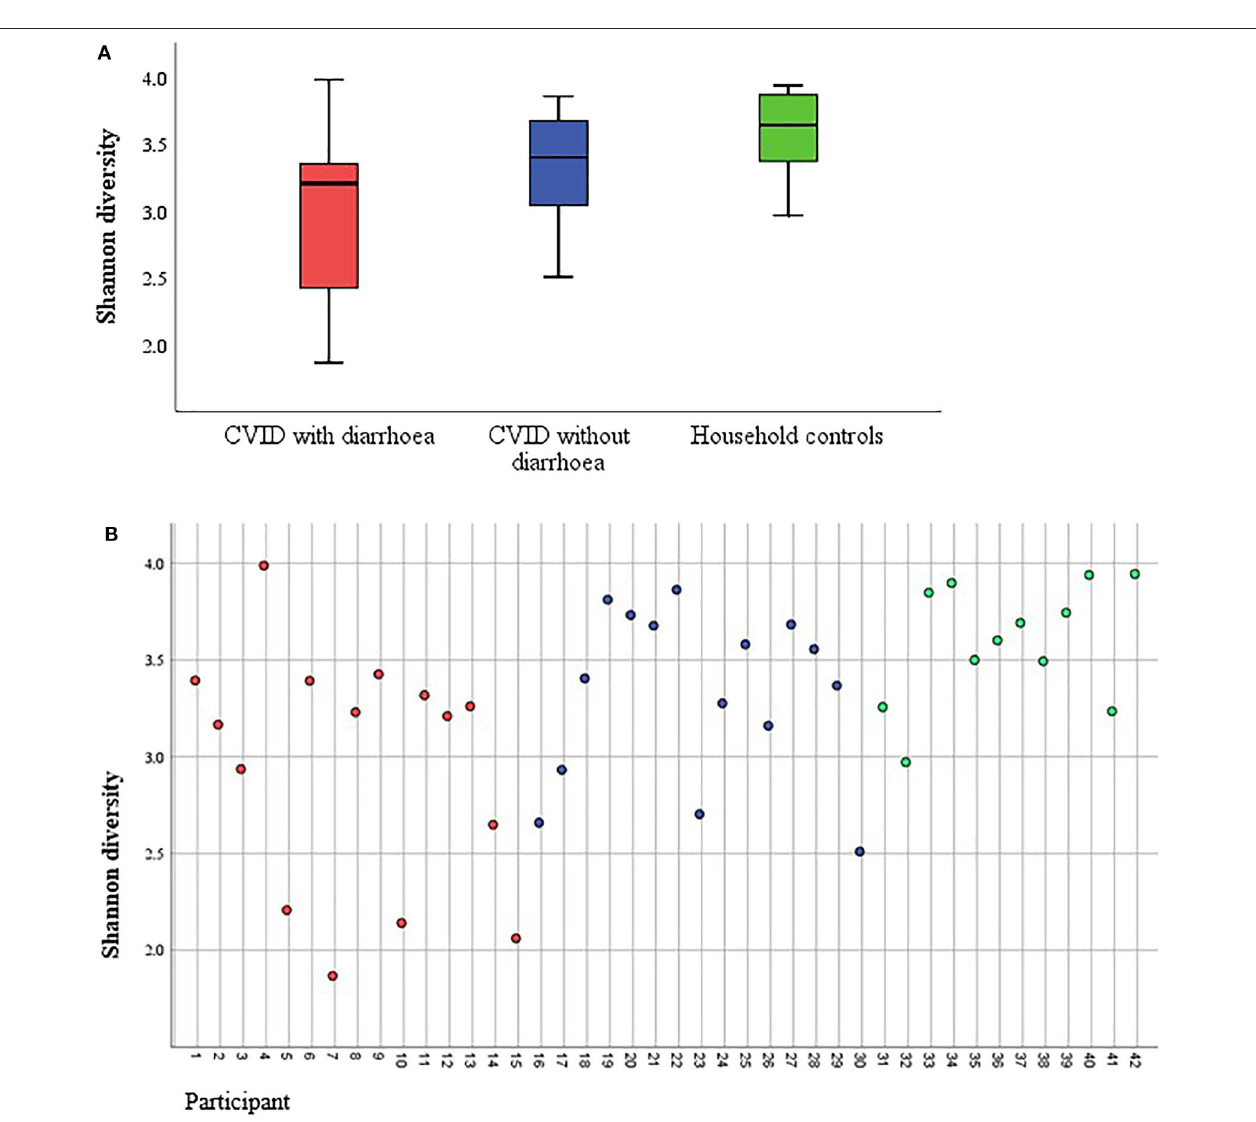
FIGURE 6 | (A) Boxplot of stool microbiota alpha diversity in CVID patients with and without diarrhoea, and household controls without immune deficiency. Alpha diversity depicted with Shannon diversity. (B) Alpha diversity presented as Shannon diversity for every participant. Red, CVID with diarrhoea; blue, CVID without diarrhoea; green, household controls. Three of the patients with diarrhoea were assumed to have been norovirus positive (No. 2, 10, and 15). No. 4 was sapovirus positive and No. 9 was positive for Giardia lamblia. No. 6 had CMV-inclusions in a previous ileal